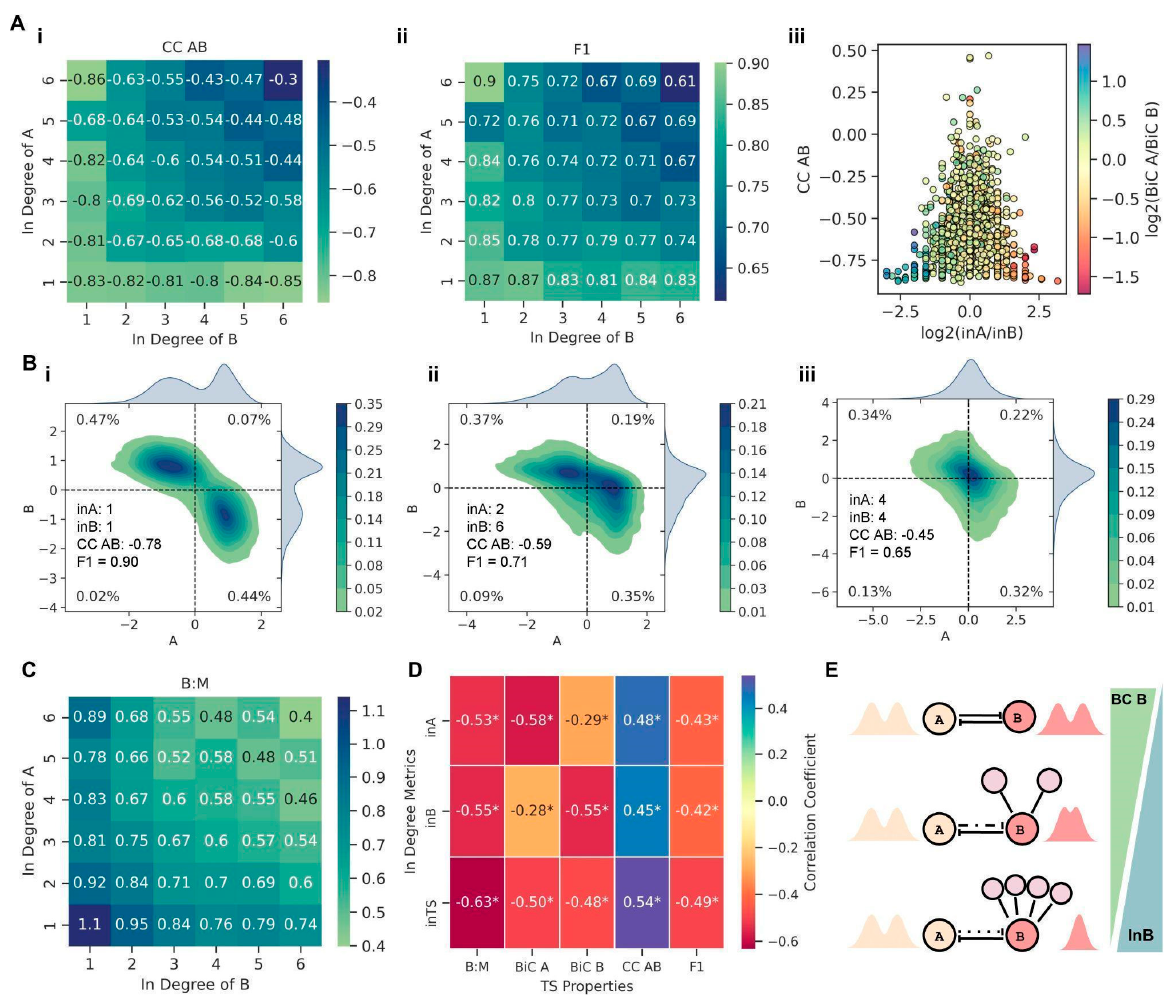
Figure 4. Influence of in-degree of TS on its functional traits. ( A ) Heatmaps of values of (i) CC AB and (ii) F1 for varying in-degree of the two nodes in a TS. (iii) Scatter plot of log 2 (in A/in B) values against their CC AB values, with points colored according to their log 2 (BiC A/BiC B) values. ( B ) Bivariate plots of steady state values of TS nodes with varying in-degree combinations (i) inA = 1 and inB = 1, (ii) inA = 2 and inB = 6, and (iii) inA = 4 and inB = 4 ( C ) Heatmap of the ratio of the fraction of bistable parameter sets which show ‘single-positive’ (01 or 10) steady states to the fraction of monostable parameter sets showing 01 or 10 steady states (B:M), with varying in-degree combinations for the two nodes of a TS. ( D ) Heatmap of the pairwise correlation coefficients of in-degree metrics, in-degree of A (in A), in-degree of B (in B) and in-degree of TS (in TS) against various TS properties. *: p -value < 0.05 according to Spearman correlation test. ( E ) Summary of the effect of local density on the dynamics of an embedded TS